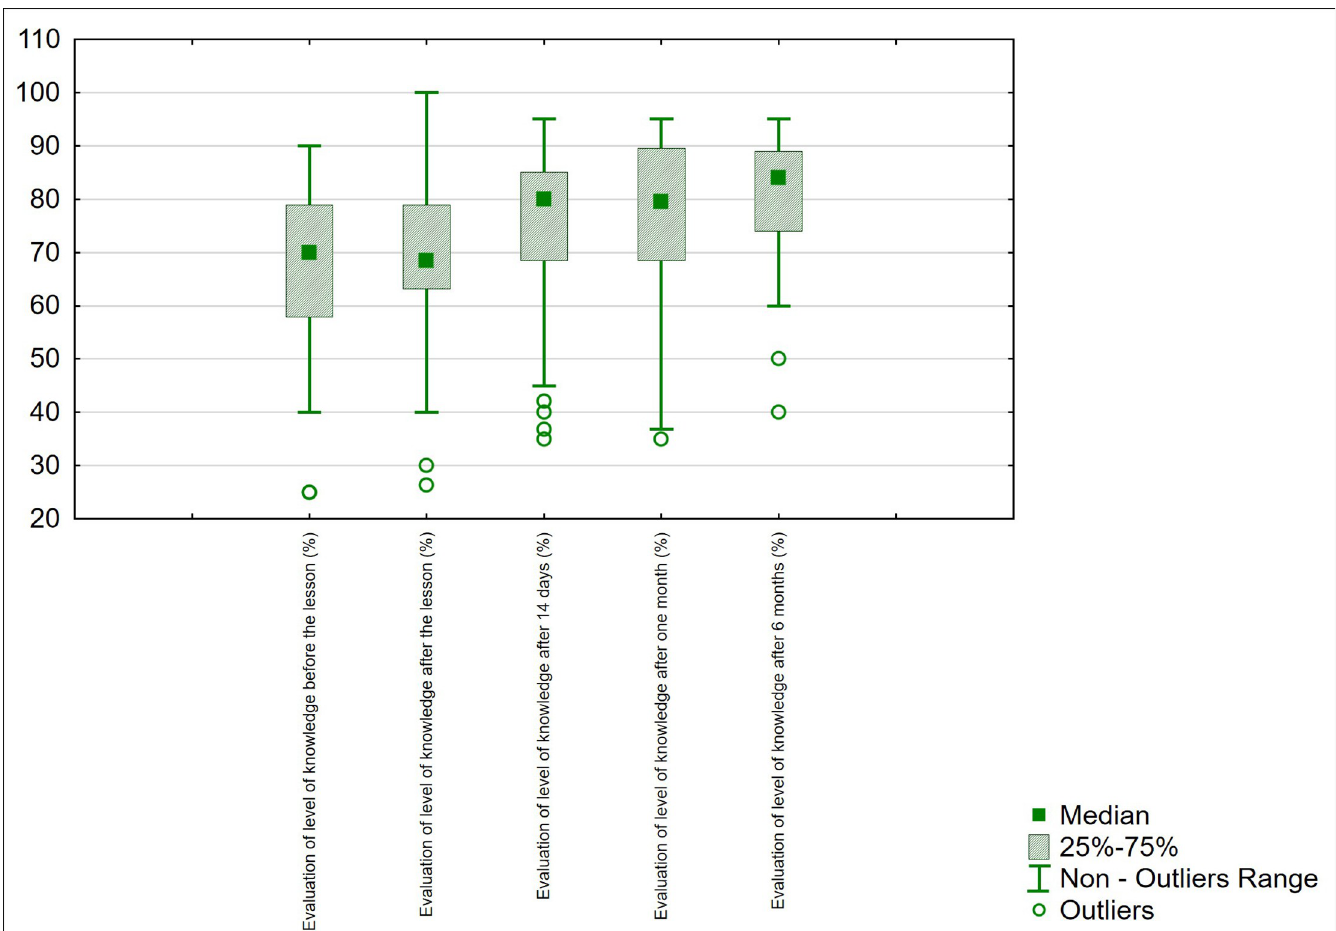
found in Table 1. The results obtained for children participating in the lesson at the farm dis- played over time can be found in Fig 2. Overall, there was no significant difference in students’ proficiency levels over time (p = 0.215) for students who attended the lesson in the classroom. This difference was observed when comparing knowledge before and after the lesson (p < 0.001). No significant difference was observed when comparing knowledge immediately after the lesson and 14 days later (p = 0.193). The difference between the level of knowledge reported 14 days after the lesson and one month after the lesson was not significant (p = 0.294), as well as when comparing the